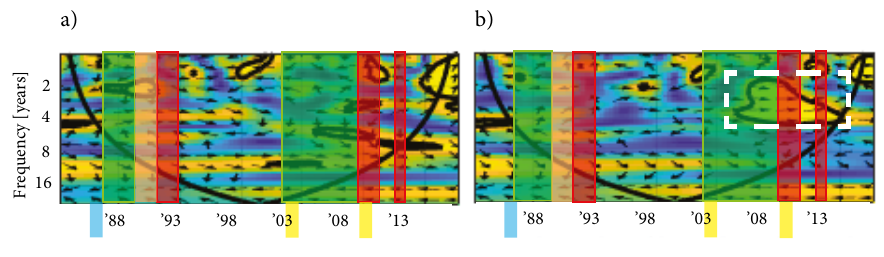
Figure 4. Wavelet coherence between: a – M3 and stock prices; b – bank credit and stock prices for the UK (source: own